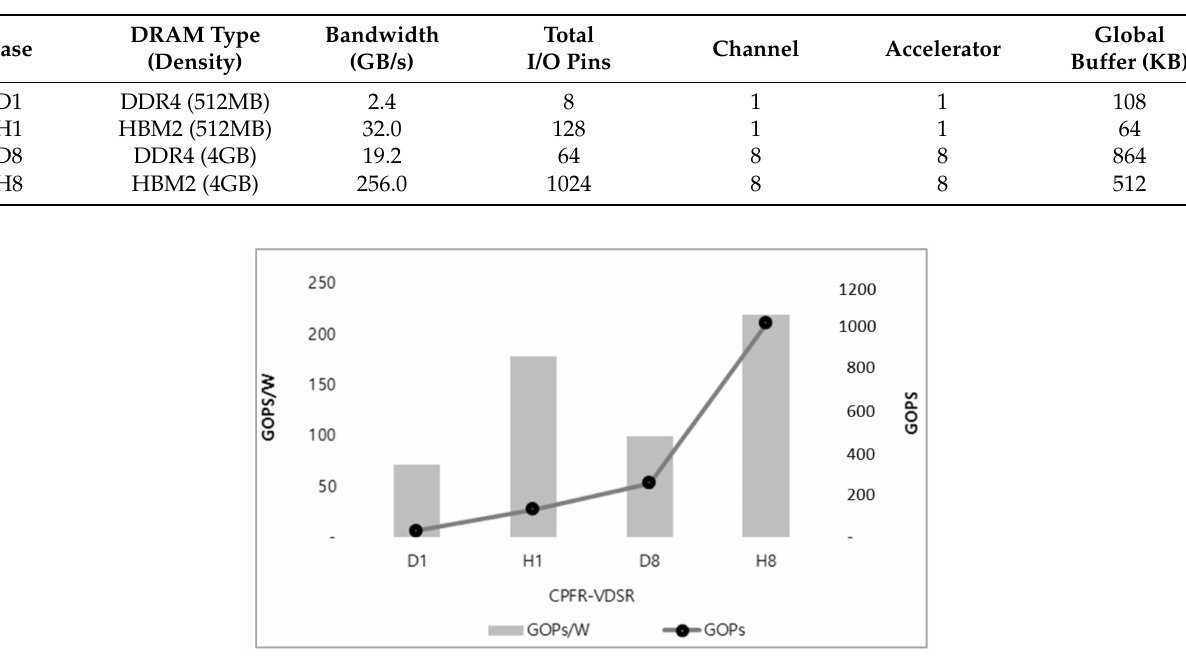
Table 3. A comparison of the cases.